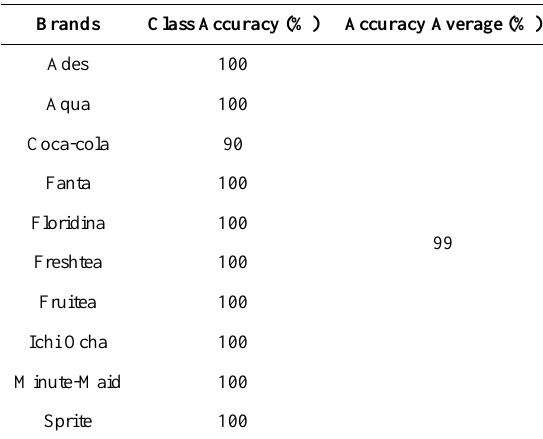
Table 1. Result Testing